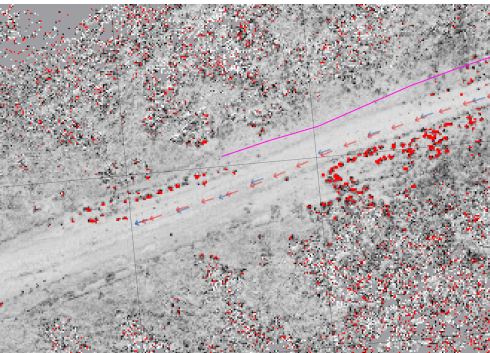
Figure 11. Costmap-Based Localization (CBL) on a static Persistent Map built without GPS. The GPS track, shown in magenta, is not available to the state estimator. The blue arrows indicate the localizations generated by the costmap based localization, and the red arrows show the Kalman filter-based state estimator that incorporates wheel encoders, inertial measurements, and gyroscope inputs with the localization results.